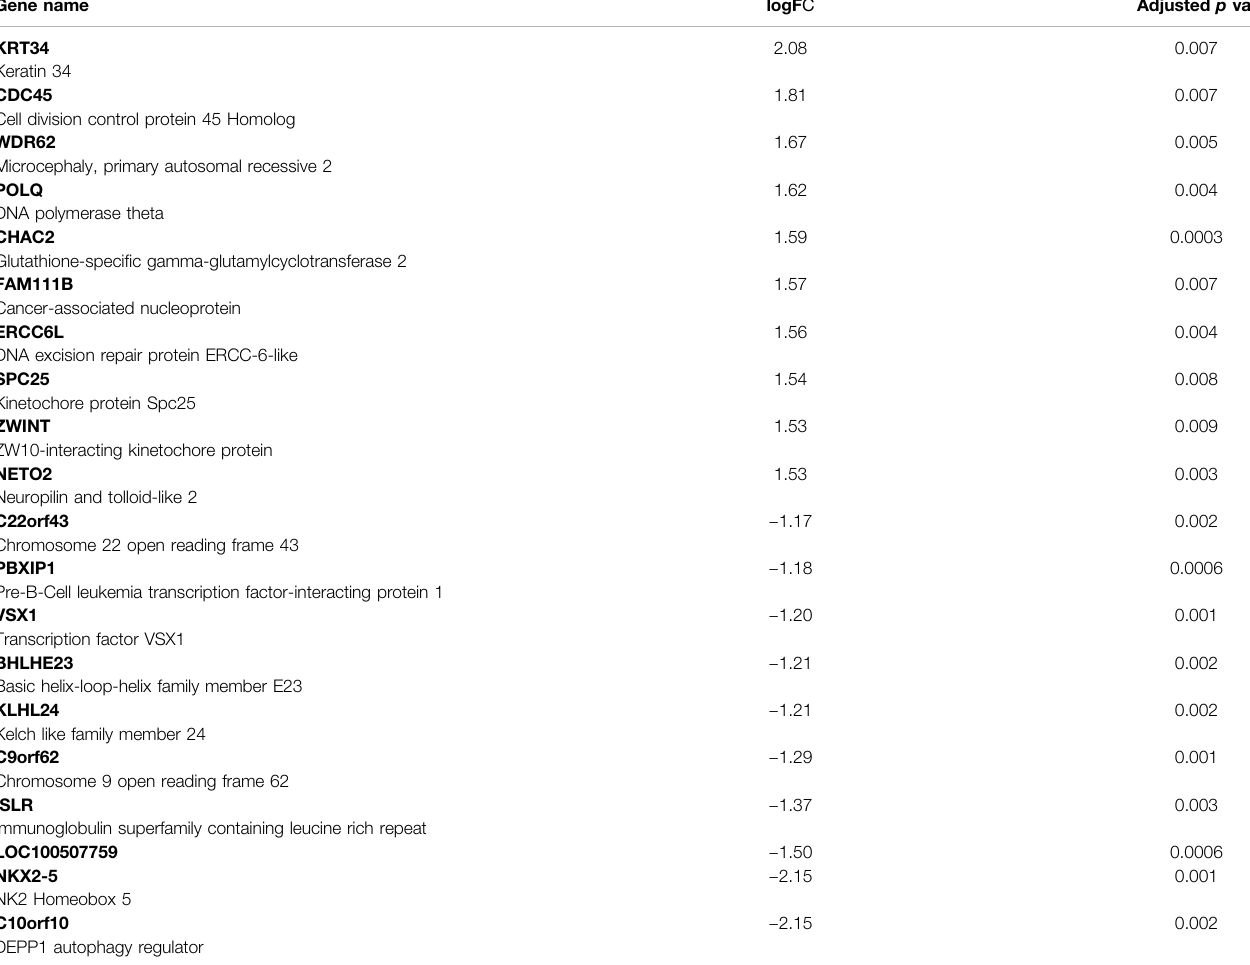
TABLE 1| Top 10genesupregulated andtop 10downregulatedintheexposedhuman salivary glandcells lineto2.5 µM ofMeHgvs.nonexposedcells (MeHgvs.